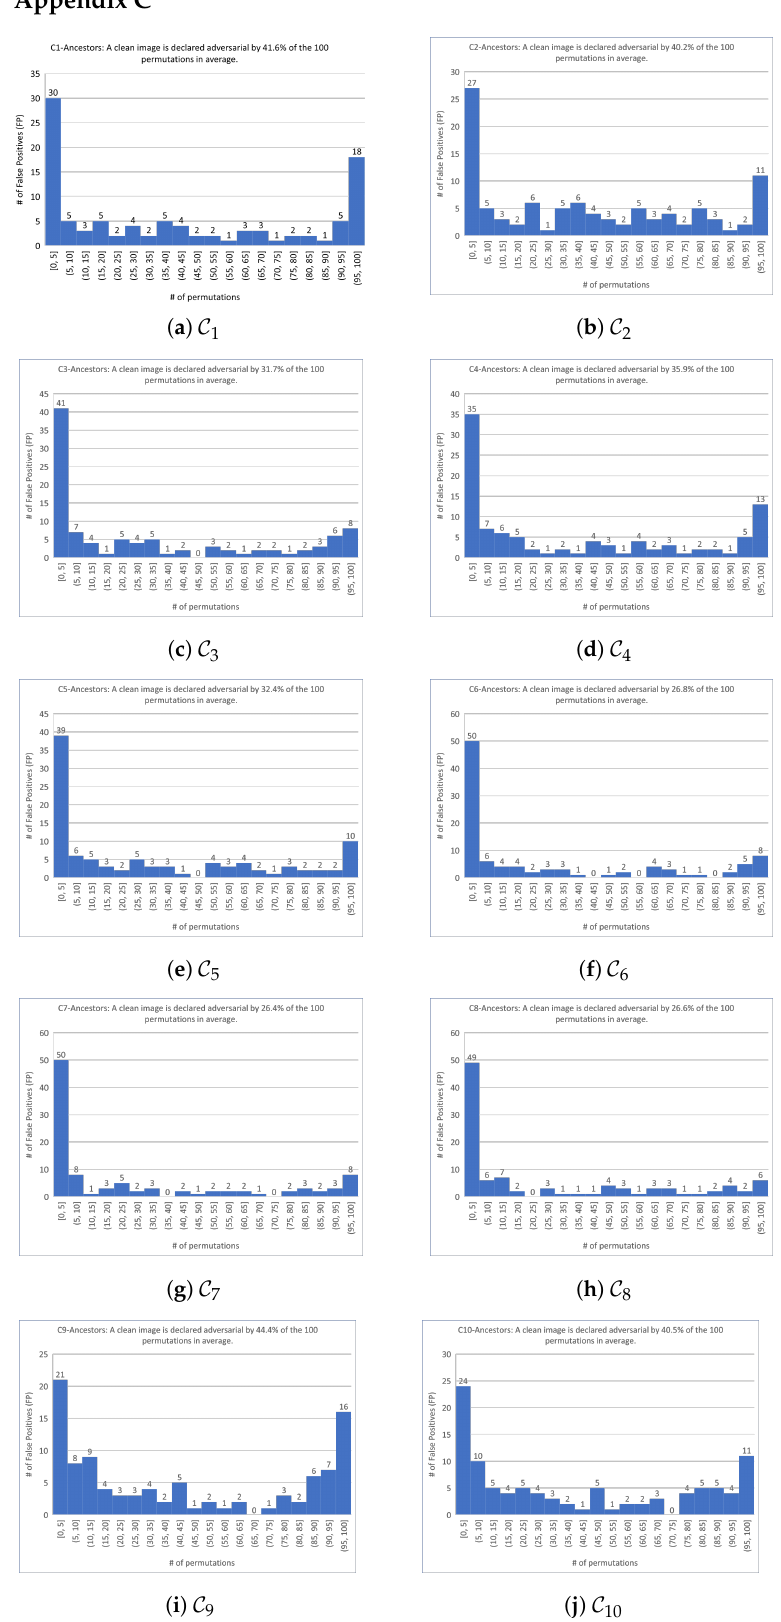
Figure A2. Shuffling test results of 100 clean (ancestor) images on C = C for 1 ≤ k ≤ 10 over 100